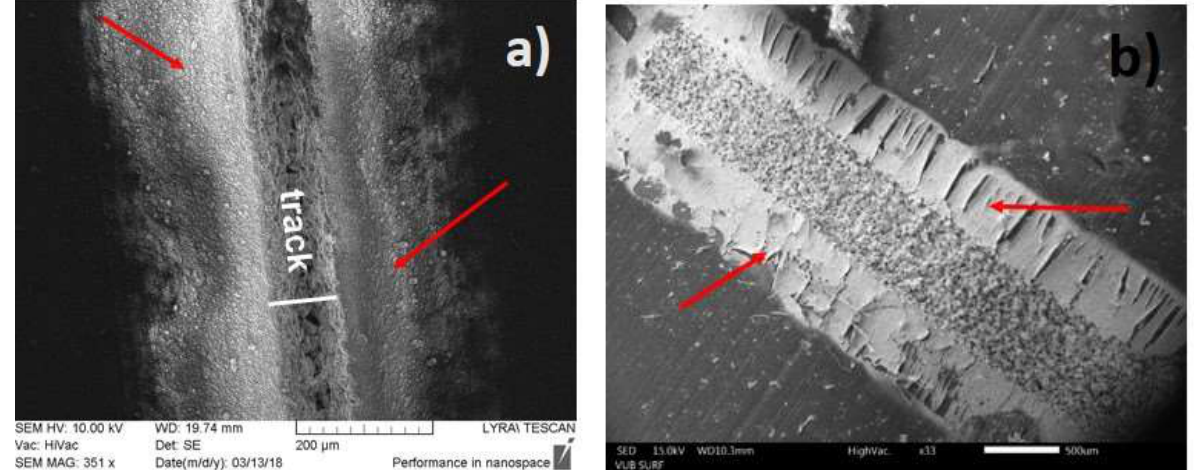
Figure 4. ( a ) Laser track after ns-laser ablation of PDMS sample in air with a wavelength of 266 nm, the beam spot is in the focal plane, the red arrows show the debris beside the track; ( b ) Pt (platinum) coating deposited by electroless metallization of a track obtained by ns-laser ablation of PDMS sample in air with 266 nm wavelength, the beam spot is out of the focal plane, the red arrows show the debris beside the track, on which enough quantity of Pt is deposited.